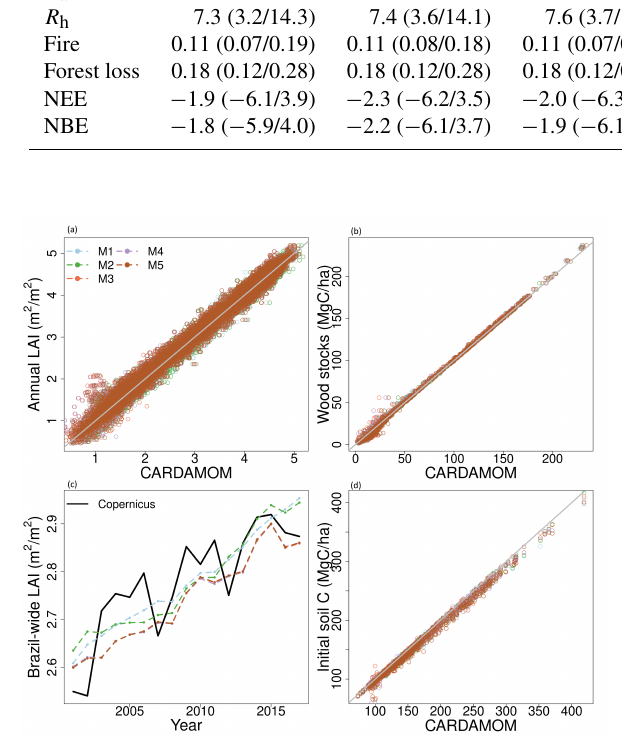
Figure 3. Comparison between observational constraints used to calibrate the DALEC models and the corresponding model out- puts. The grey line (a,b,d) shows the 1 : 1 line. LAI is presented as a pixel-wise comparison of the mean annual LAI (a) and as a Brazil-wide average time series highlighting the long-term trend of increasing LAI (c) . The colours of the lines shown in panel (c) rep- resent the different models matches that are shown in the legend in panel (a)